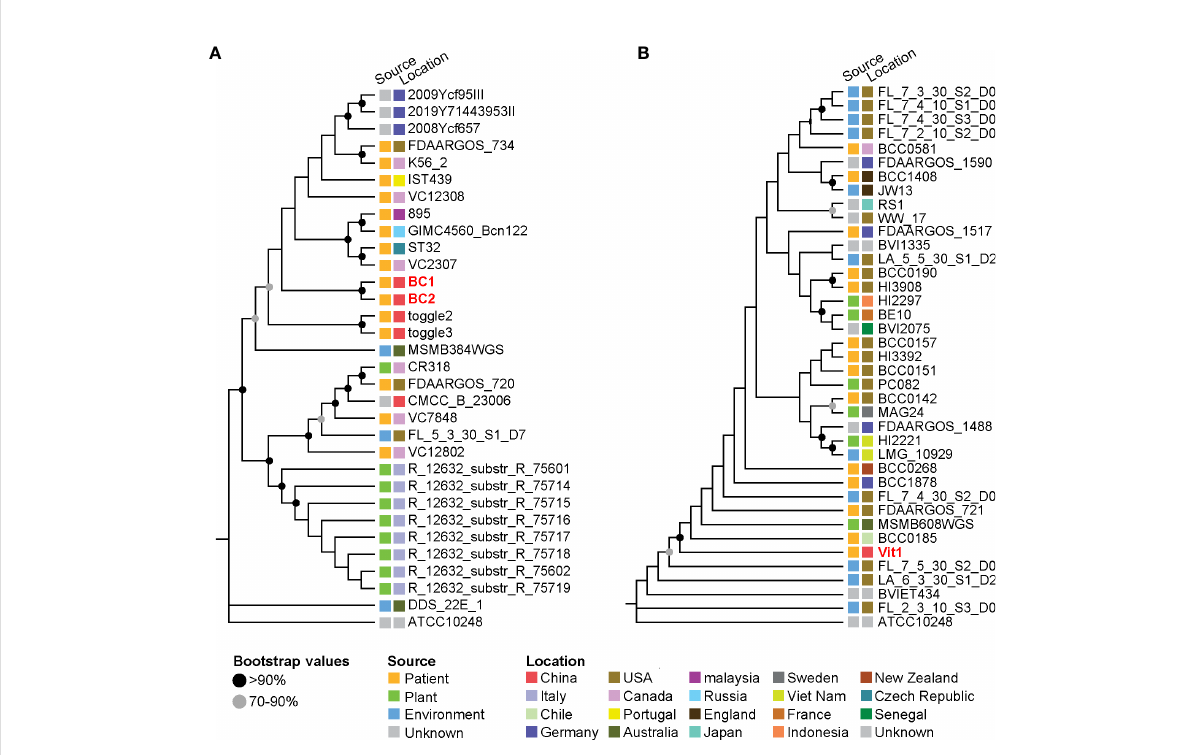
FIGURE 3 Phylogenetic trees of Burkholderia strains based on core single-nucleotide polymorphisms. (A) Phylogenetic tree of B. cepacia strains. (B) Phylogenetic tree of B. vietnamiensis strains. The squares beside the strains denote the source and location of the